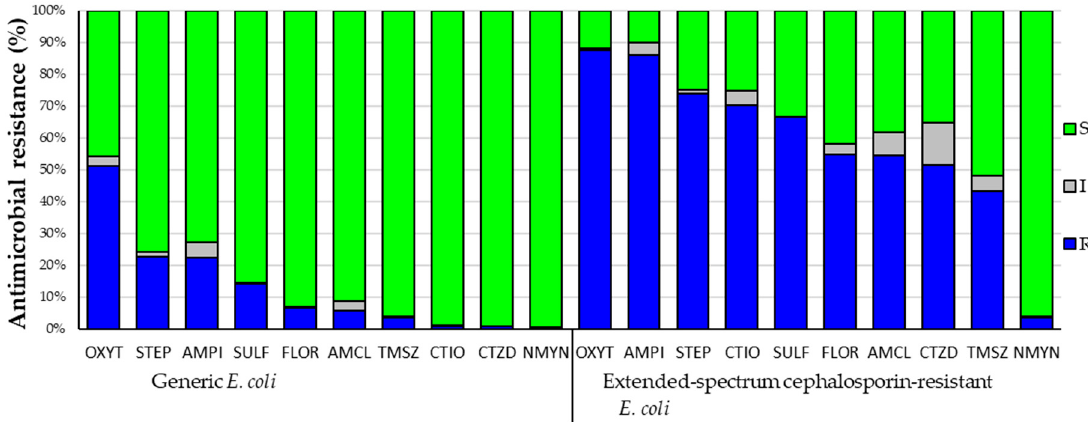
Figure 2. Antimicrobial resistance distribution among generic ( n = 663) and extended-spectrum cephalosporin-resistant ( n = 705) Escherichia coli . Legends: S—Susceptible; I—Intermediate; R—